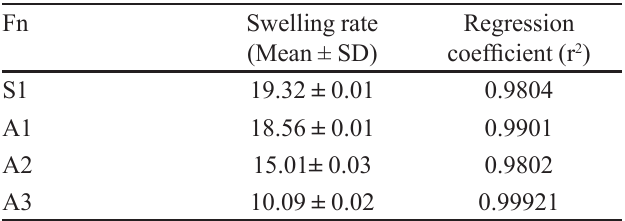
TABLE IV - Swelling characteristics of sodium alginate (Na- alginate) beads and hydrophobic hydroxypropyl methylcellulose (HPMC)/Na-alginate beads